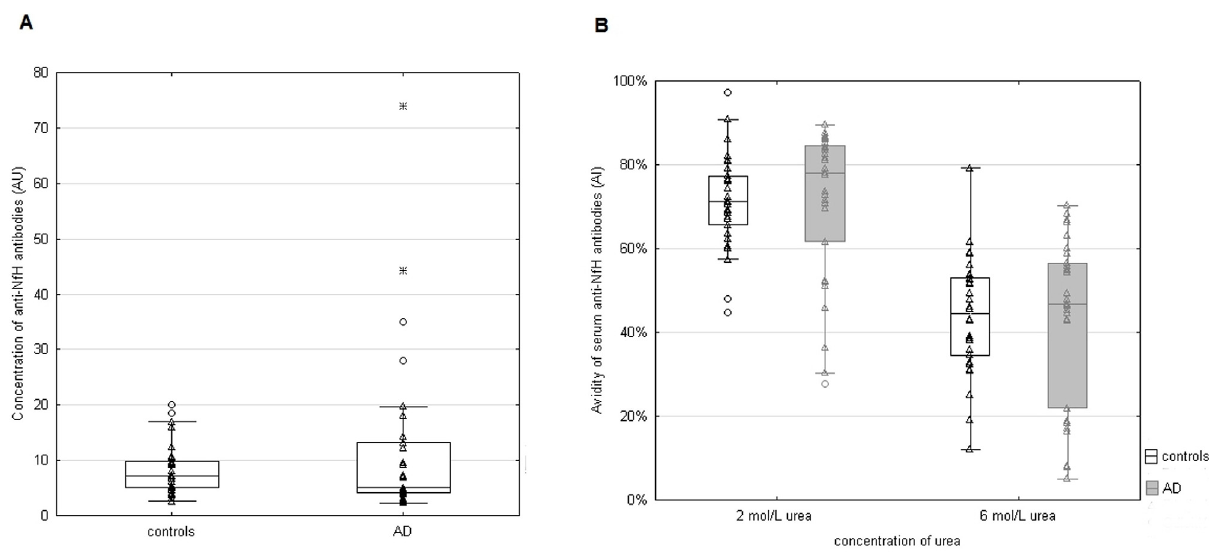
Fig. 3. Comparison of serum levels and avidities of anti-NfH antibodies IgG in the group of Alzheimer’s disease patients (n=30) and in the control group (n=30).